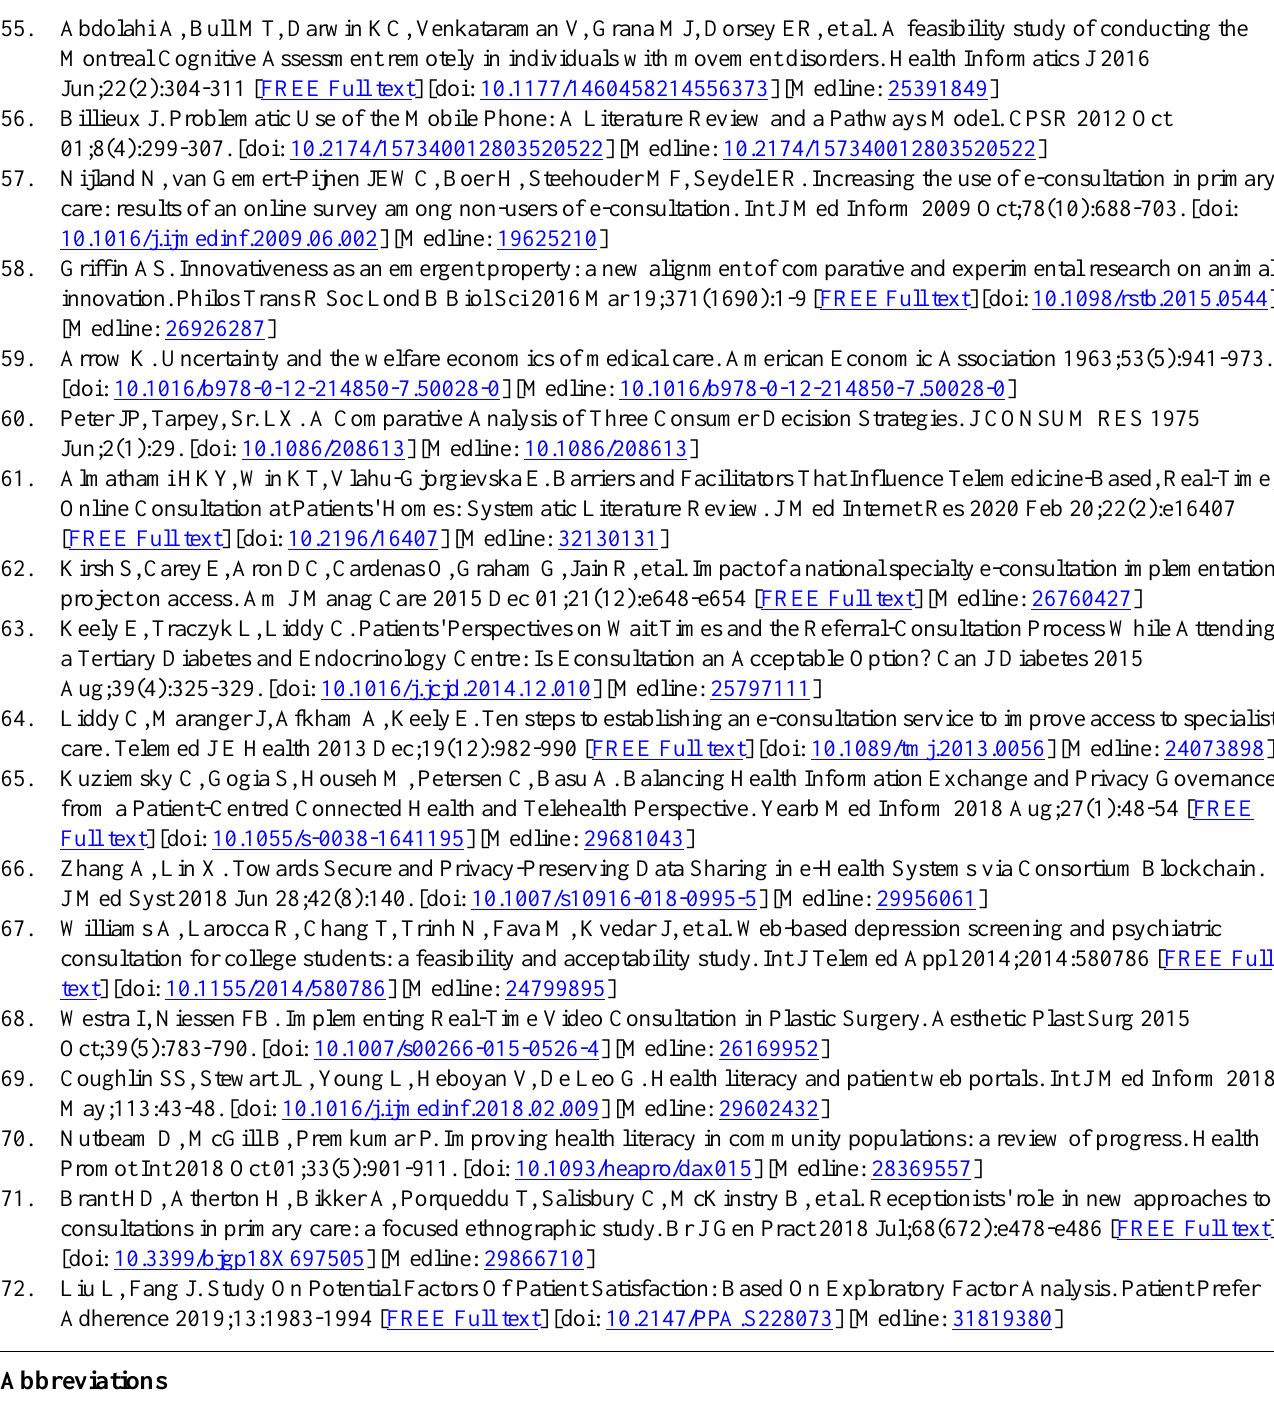
CHERRIES: Checklist for Reporting Results of Internet E-Surveys TAM: technology acceptance